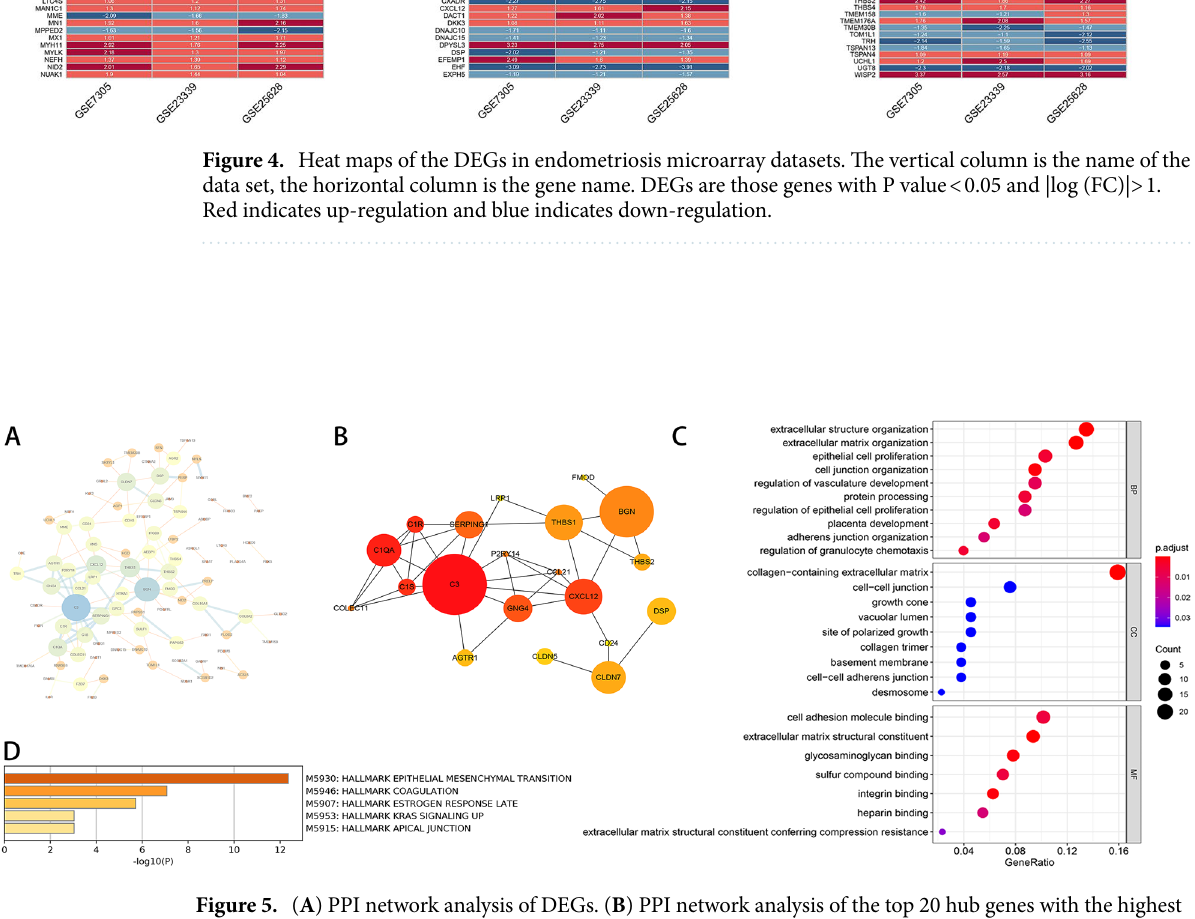
Figure 5. ( A ) PPI network analysis of DEGs. ( B ) PPI network analysis of the top 20 hub genes with the highest scores. The size of the circle is related to the score. ( C ) GO analysis of DEGs in endometriosis. The result of GO analysis was divided into three parts: biological process (BP), cellular component (CC), and molecular functions (MF). The color of the circle was related to the P-value and the size of the circle was related to the count. ( D ) Hallmark pathway enrichment of DEGs in endometriosis. Pathway enrichment of DEGs in endometriosis was visualized on a bar chart, showing -Log10